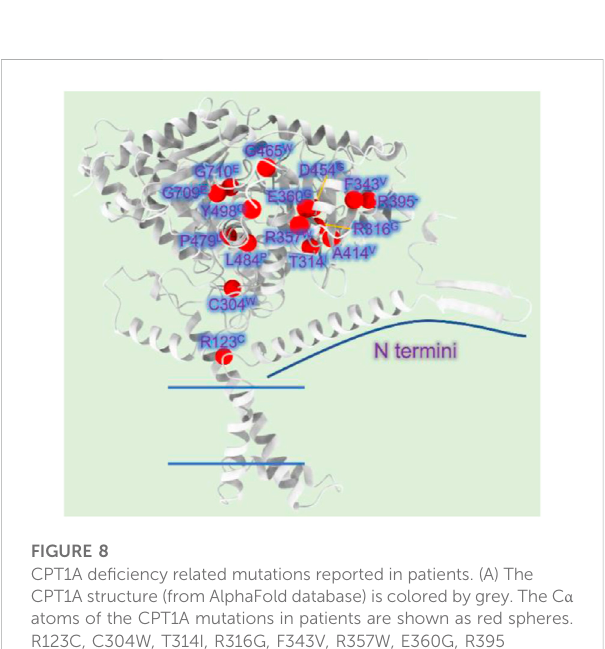
FIGURE 8 CPT1A de fi ciency related mutations reported in patients. (A) The CPT1A structure (from AlphaFold database) is colored by grey. The C α atoms of the CPT1A mutations in patients are shown as red spheres. R123C, C304W, T314I, R316G, F343V, R357W, E360G, R395 (missing), A414V, D454G, G465W, P479L, L484P, Y498C, G709E, and G710E are among the missense mutations discovered in